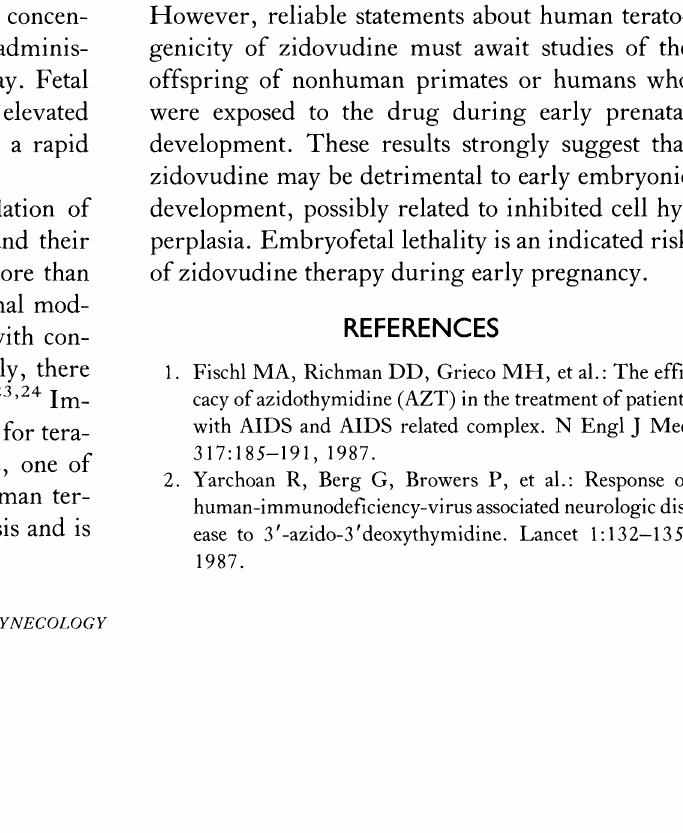
The teratogenicity of zidovudine in humans is an important issue. Twenty to fifty percent of the infants of HIV-infected women will contract the uniformly fatal disease AIDS. 4 Zidovudine has the ability to decrease the viral antigenemia in vivo and to inhibit replication and infectivity of the virus in vitro; it also has a profound effect on the frequency and severity of neonatal infection. 4’26’27 Zidovu- dine has no proven teratogenic activity in